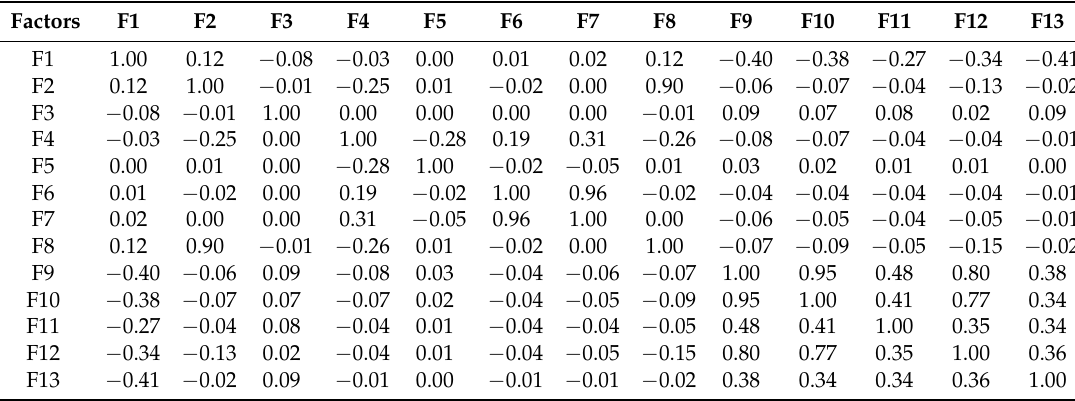
Table 4. The correlation matrix of the influencing